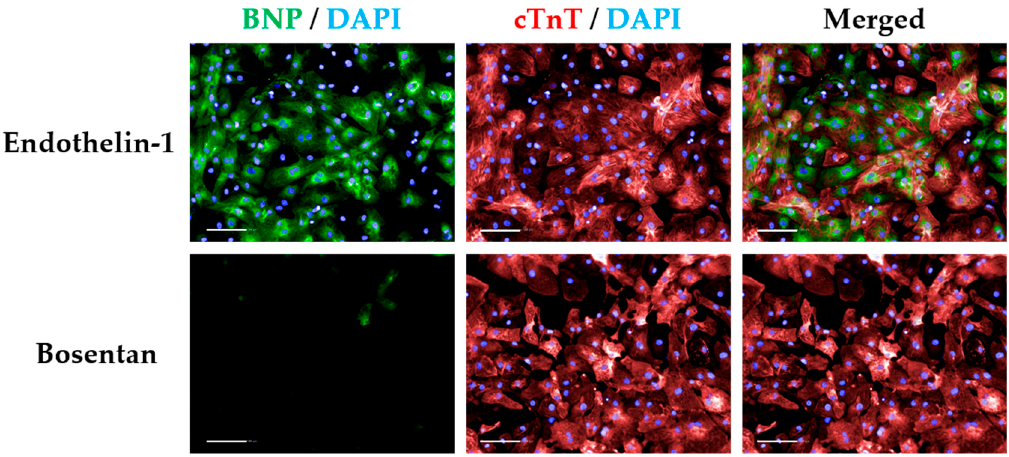
Figure A2. Controls for BNP signal thresholding. In order to categorize signal intensities of cardiomyocytes expressing BNP, endothelin-1 treatment can be used to determine high-intensity threshold as it maximises BNP expression relative to untreated cells, whereas bosentan treatment has the opposite effect (defining low/nonexistent signal). Scale bar = 100 μ m.